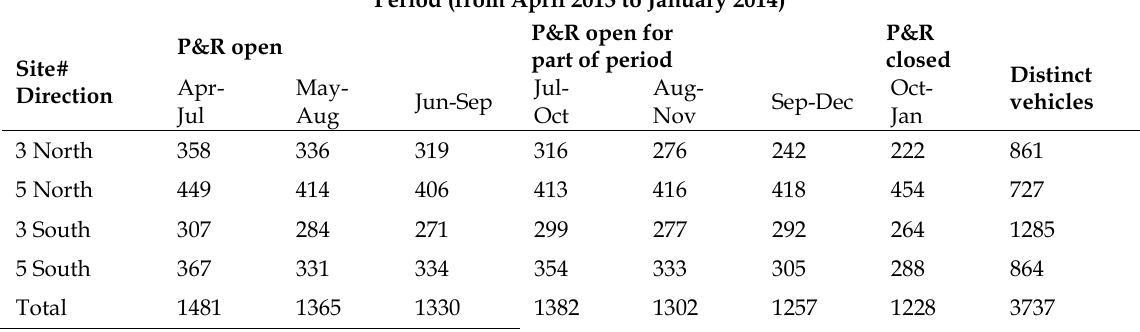
Table 5. Number of regular vehicles (N ≥ 30, σ≤ 10) at selected sites over